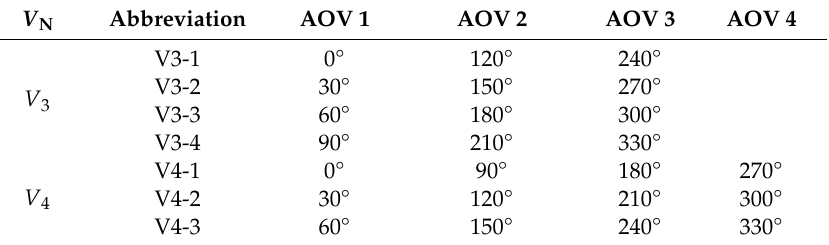
Table 1. Combination of di ff erent reconstruction